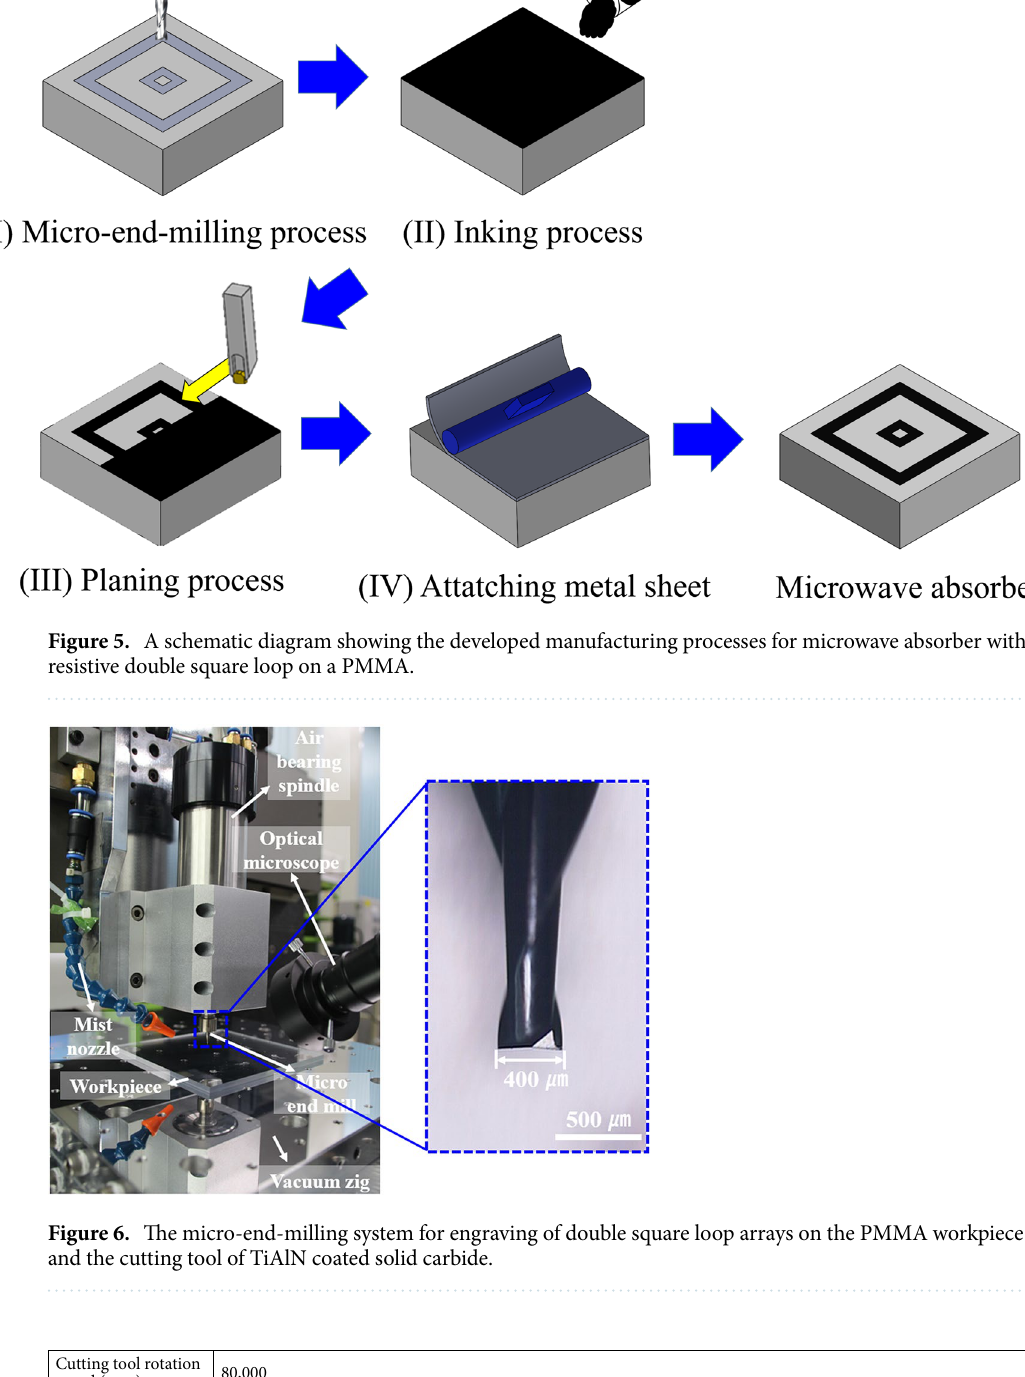
Cutting tool rotation speed (rpm)